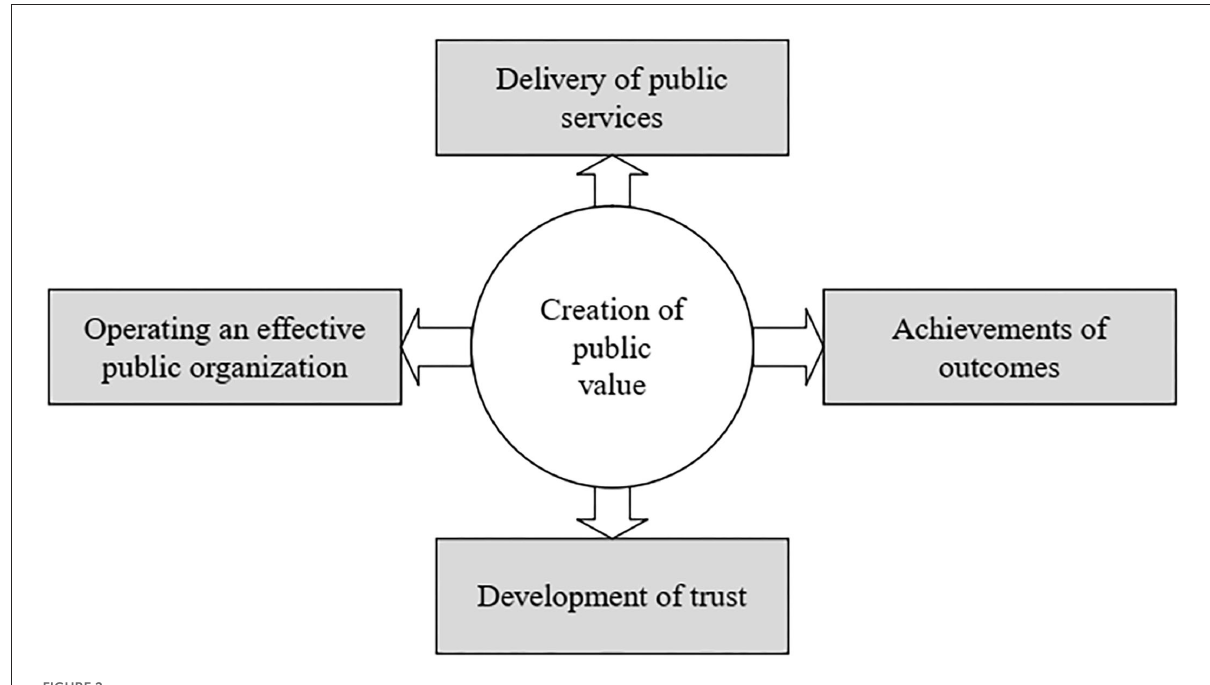
FIGURE2 Sources of e-government public value creation (Karunasena et al.,